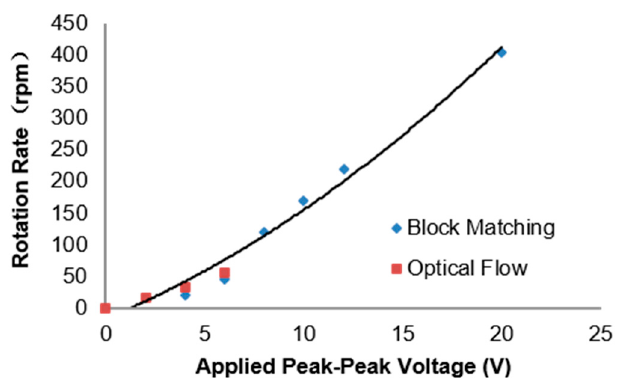
Figure 11. Calculated rotation velocity of the Melan-A cell in a 0.2 M sucrose solution versus the applied